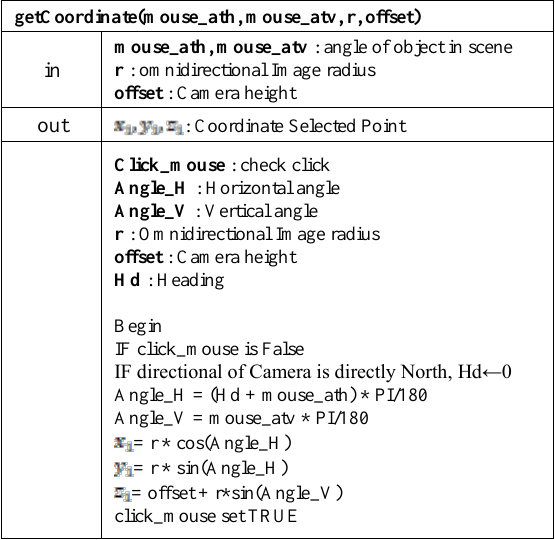
Figure 7. Pseudocode for calculating coordinates